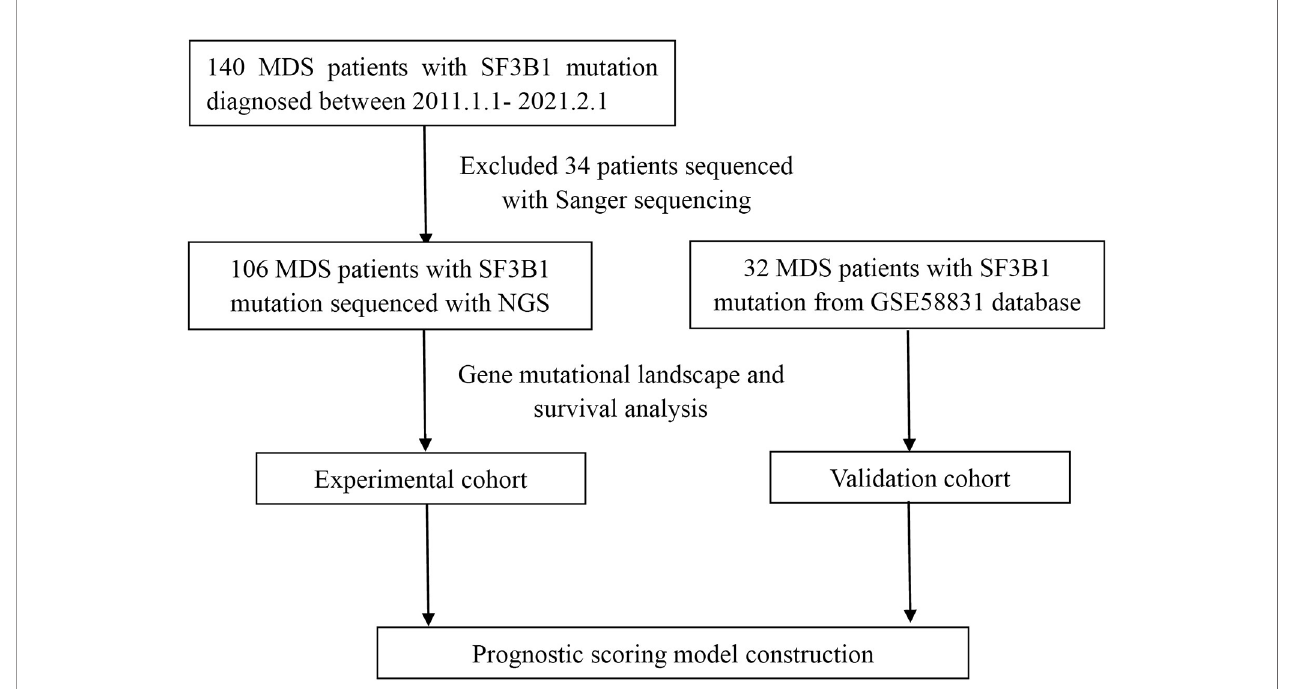
FIGURE 1 | Flowchart of MDS patients with SF3B1